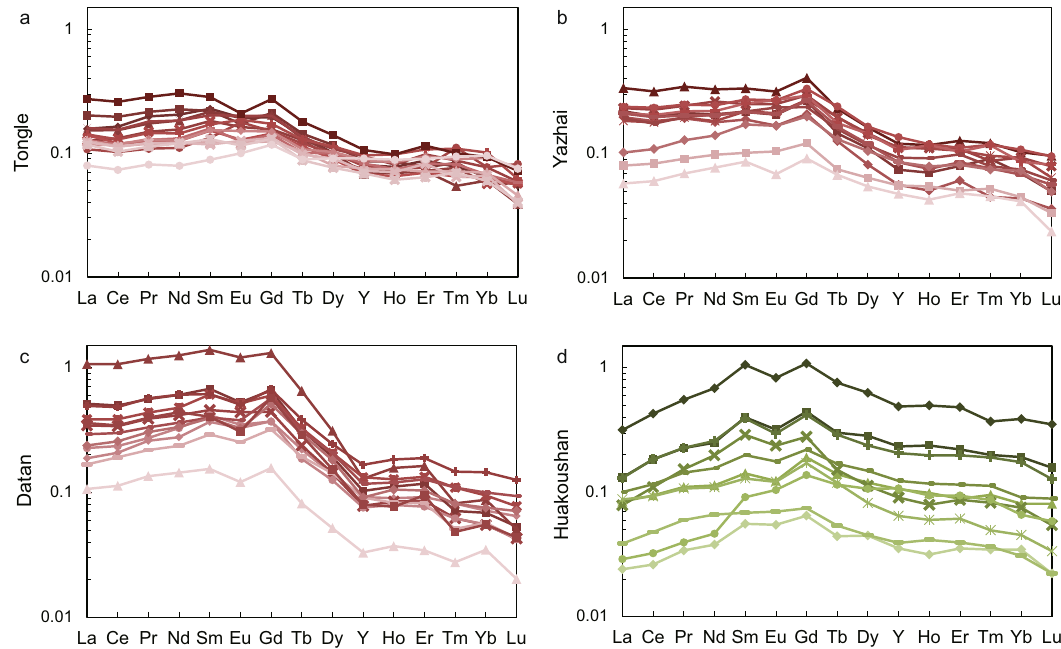
Fig. 4 Rare earth element pattern of the Nantuo pyrite. Rare earth element (REE) data are normalized to post-Archean Australian shale (PAAS). Samples formed in the basin environment (Tongle, Yazhai, and Datan section) are strongly depleted in HREE. Samples from the slope region (Huakoushan section) enrich in